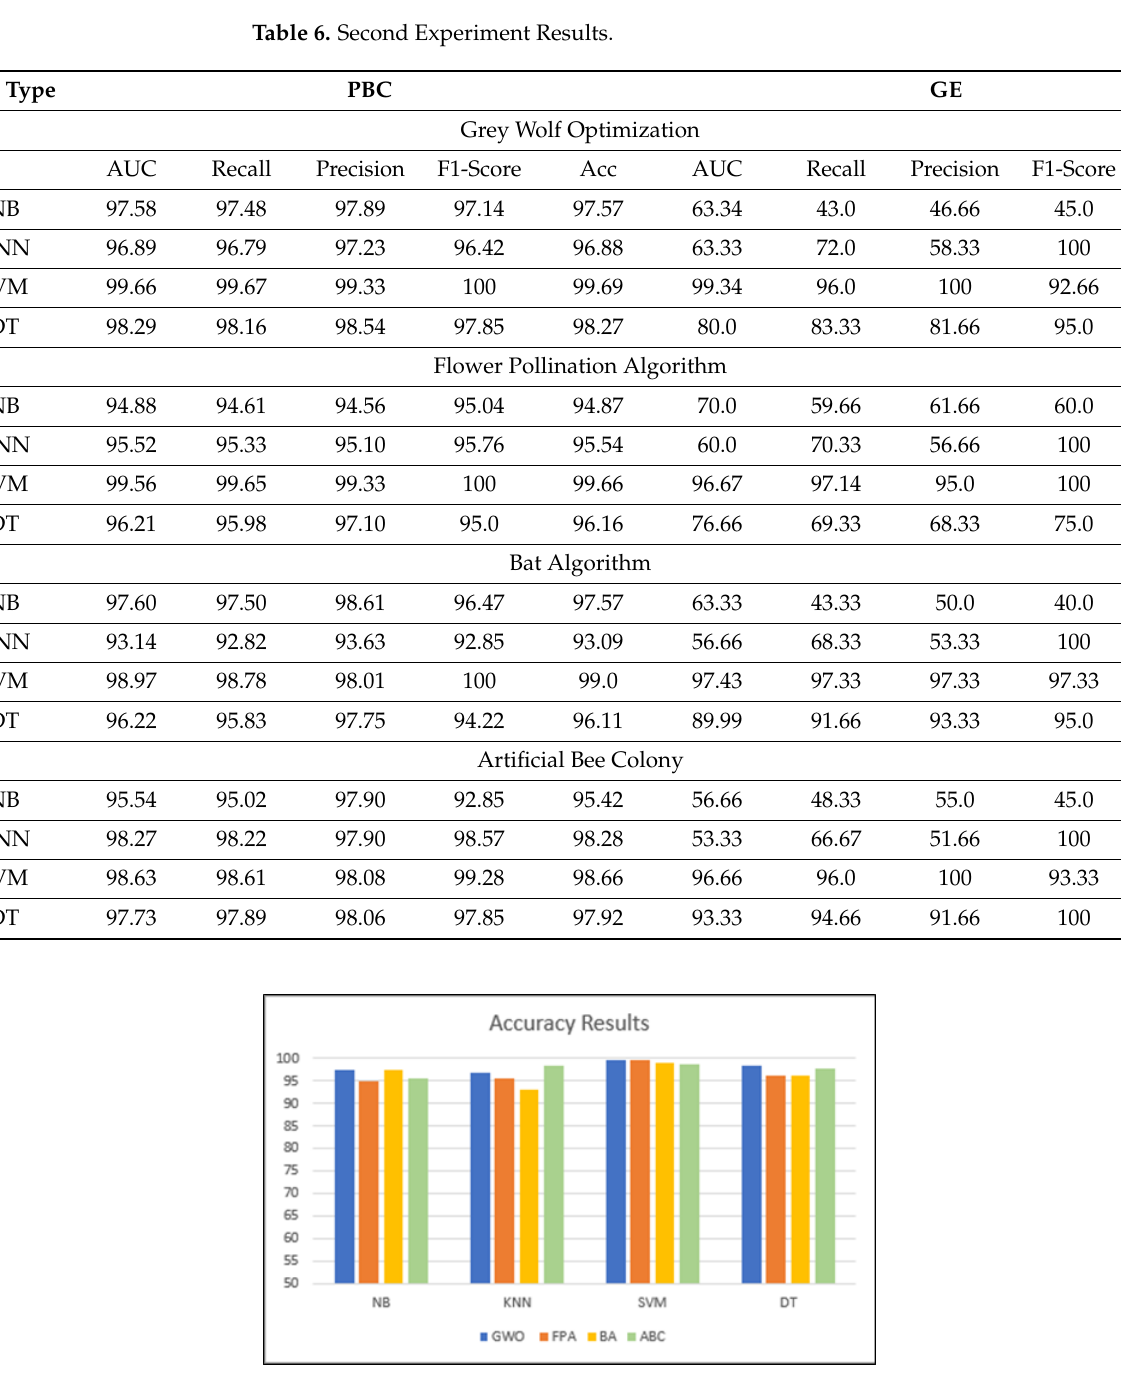
Figure 3. Comparison of accuracy between proposed models on PBC dataset.